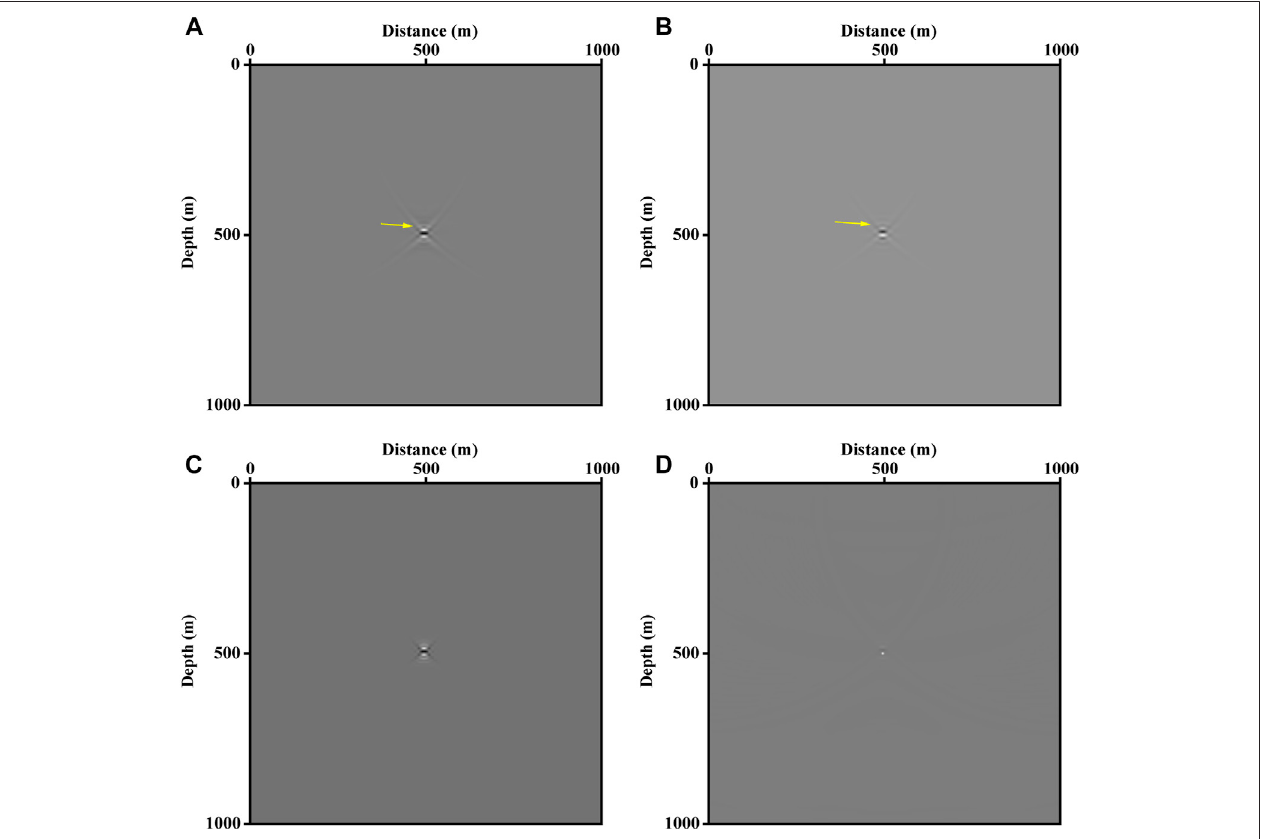
FIGURE 5 | The images invert by LSRTM and LSRTM with L1 norm constraint based on Born and Kirchhoff approximation. (A) Unconstrained LSRTM based on Born approximation. (B) Unconstrained LSRTM using Kirchhoff approximation. (C) The image of the LSRTM with L1 norm regularization based on Born approximation. (D) The migrated image with sparse constrained LSRTM based on Kirchhoff approximation.